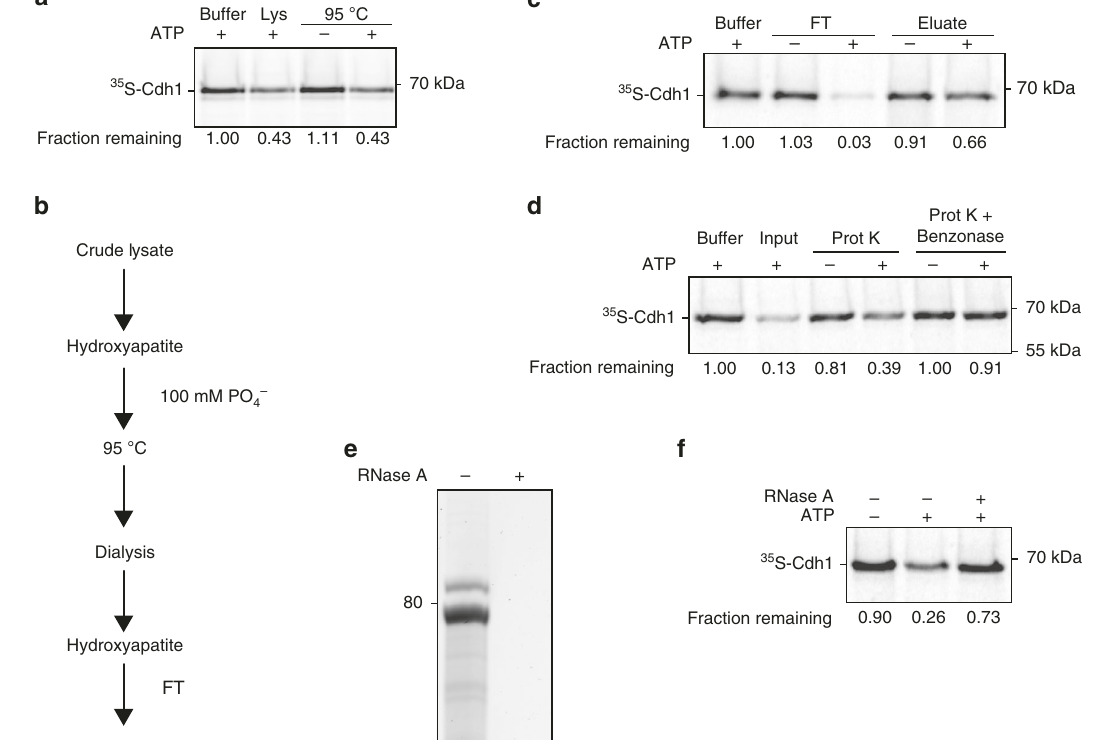
Fig. 2 RNA in cell lysate is necessary and suf fi cient for activator dissociation. a Cdh1 dissociation from APC/C was measured after 45 min in the presence of lysis buffer or yeast lysate, either untreated (Lys) or incubated at 95 °C for 10 min. Prior to the experiment, boiled lysate was gel fi ltered and concentrated fi ve-fold. Dissociation reactions were performed with or without 5 mM ATP as indicated. Uncropped autoradiograph and source data are provided in the Source Data fi le. b Puri fi cation steps in the preparation of the dissociation activity used in panels c – f . Dissociation activity was found in the fl ow-through (FT) of the second hydroxyapatite column, which was also eluted with 100 mM phosphate. c Flow-through (FT) and eluate fractions of the last hydroxyapatite step were tested in a Cdh1-dissociation reaction. Fractions were buffer-exchanged into reaction buffer containing 2.5 mM MgCl 2 . 5 mM ATP was added as indicated. The vast majority of the dissociation activity was found in the fl ow-through fraction. Uncropped autoradiograph and source data are provided in the Source Data fi le. d The hydroxyapatite fl ow-through fraction was incubated with buffer or Proteinase K (Prot K — 6 U/ml) at 37 °C for 1 h. Proteinase K was heat inactivated at 85 °C for 10 min and further inhibited with 1 mM PMSF. After Proteinase K treatment, samples were incubated with buffer or Benzonase (2000 U/ml) at 37 °C for 1 h. Samples were supplemented with 5 mM ATP as indicated. Uncropped autoradiograph and source data are provided in the Source Data fi le. e Nucleic acid species in the fl ow-through fraction were extracted with phenol – chloroform, separated by a 10% TBE urea polyacrylamide gel and stained with SYBR Safe. RNase A treatment (0.2 mg/ml) was performed at 37 °C for 30 min (right lane). f Phenol – chloroform-extracted RNA species from panel e were tested for Cdh1 dissociation with or without 3 mM ATP in the presence of a reaction buffer containing 2.5 mM MgCl 2 . RNase A treatment (0.2 mg/ml) was performed at 37 °C for 30 min (right lane). Uncropped autoradiograph and source data are provided in the Source Data fi